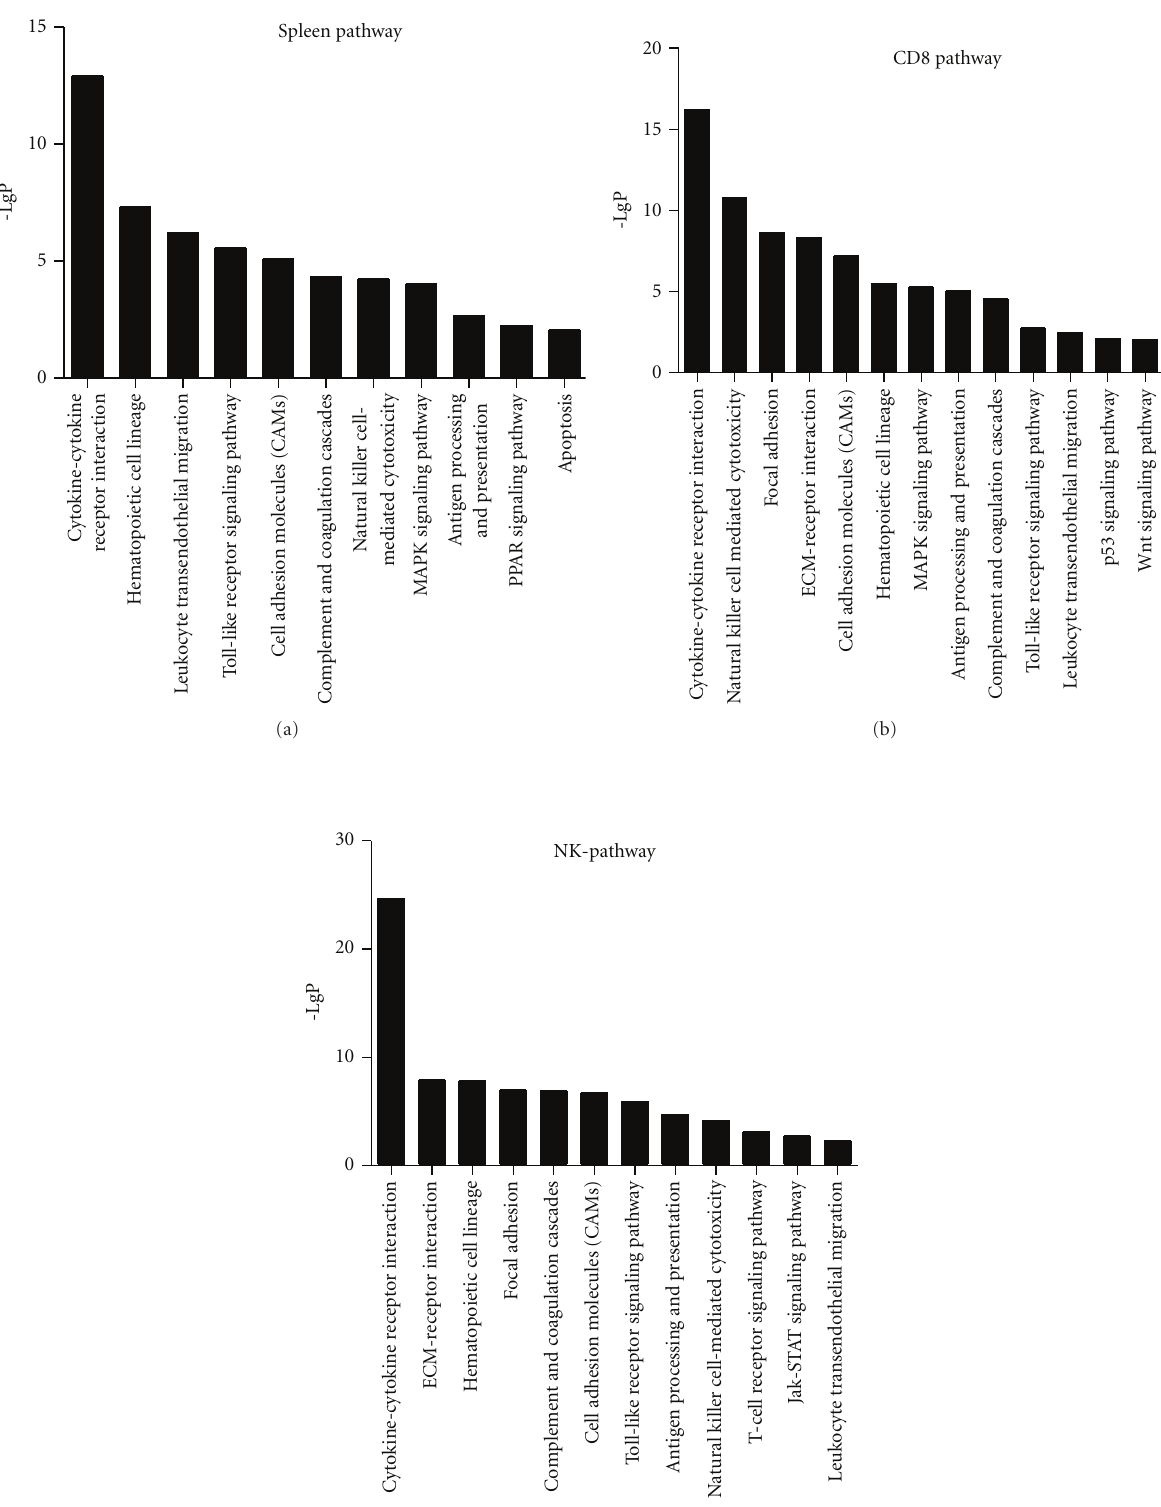
Figure 5: Significantly upregulated pathways with di ff erentially expressed genes in splenocytes, purified CD8 + cells, and NK cells in 6-week Schistosoma japonicum -infected IFNg KO mice compared with WT mice based on KEGG and GENEMAP databases. The value of “-LgP” stands for the significance of a particular pathway